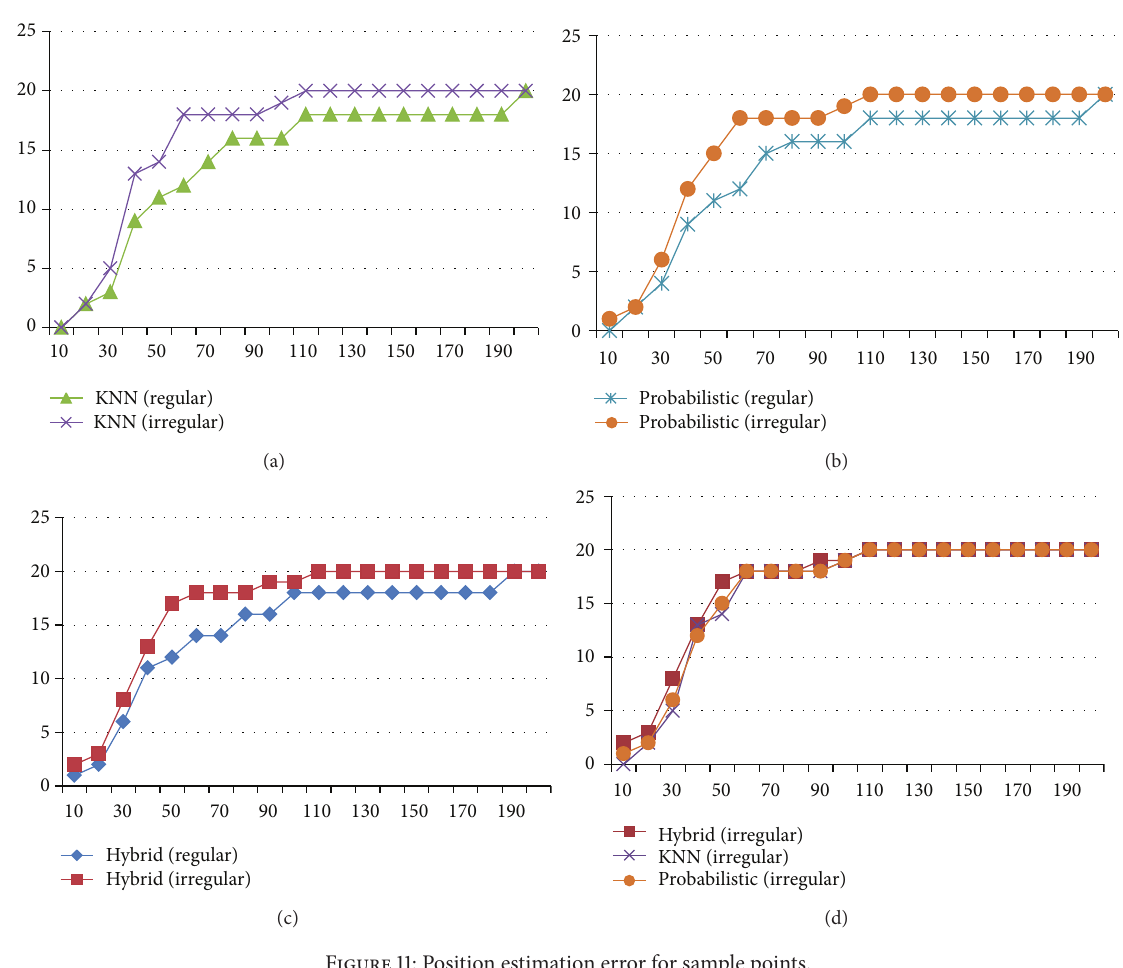
Figure 11: Position estimation error for sample points.